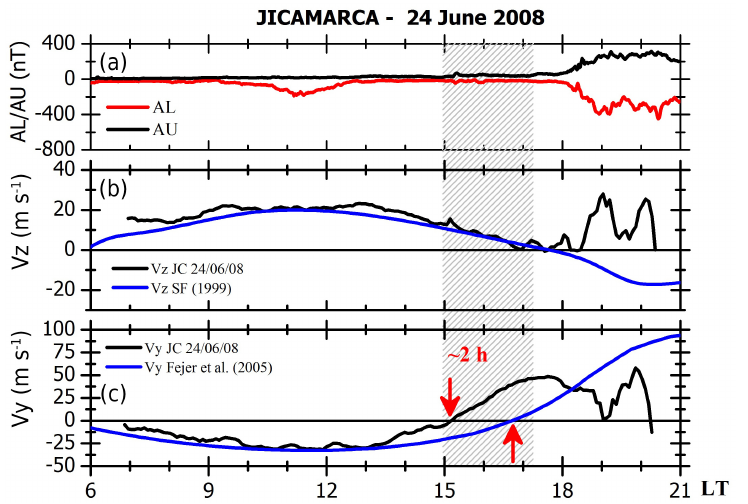
Figure 1. (a) Values for AL/AU with time resolution of 1min and (b, c) the ionospheric vertical drift ( V z ) and zonal drift ( V y ) measured by the ISR at Jicamarca on 24 June 2008. The vertical and zonal plasma drifts as per the models by Scherliess and Fejer (1999) (for V z ) and Fejer et al. (2005) (for V y ) are represented by the blue lines in panels (b, c) . The shaded area and the red arrows highlight the earlier reversal of the zonal drift to east when compared to the